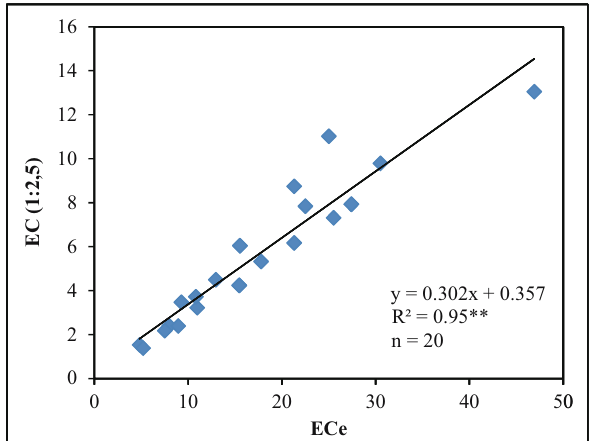
Figure 2: Correlation between EC ( 1:2.5 ) and ECe saturation